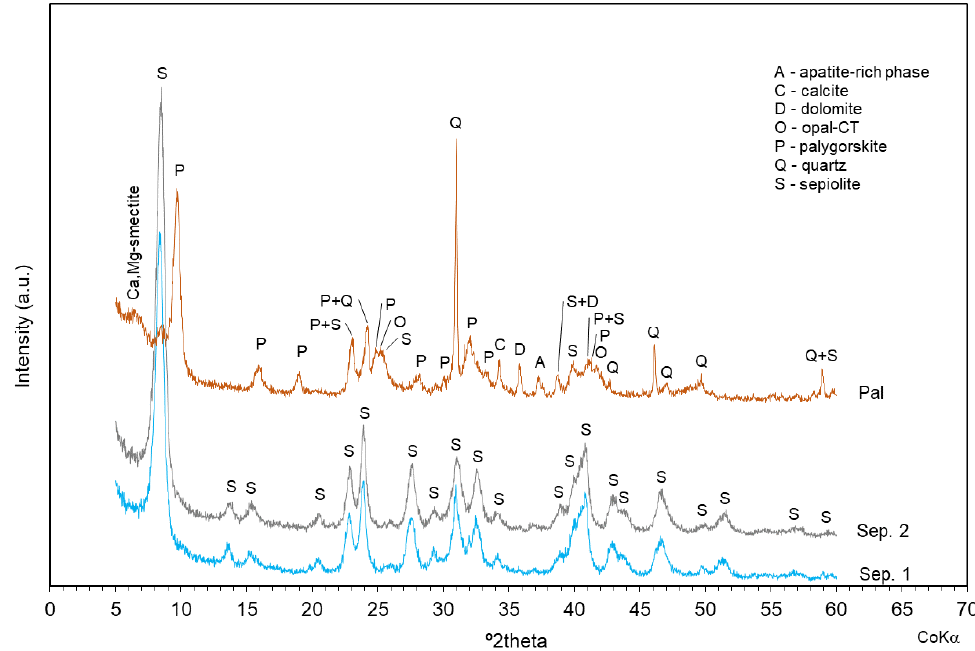
Figure 1. Mineralogical characterization of sepiolite and palygorskite samples by X-ray diffraction.